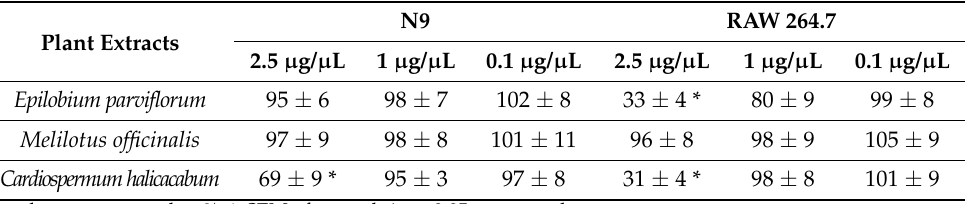
Table 3. Effect on cell viability of different dilutions of the plant extracts Epilobium parviflorum , Melilotus officinalis , and Cardiospermum halicacabum prepared in 40% ethanol on N9 microglial